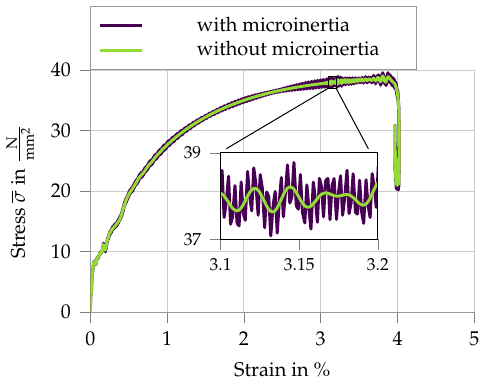
Figure 15. Analysis of the influence of microinertia on the macroscopic